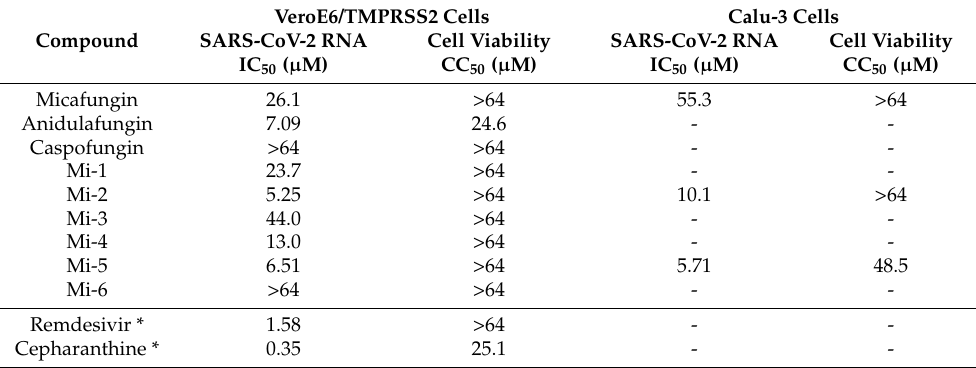
Table 1. The IC 50 and CC 50 of Micafungin and its derivatives against a SARS-CoV-2 Wuhan strain.